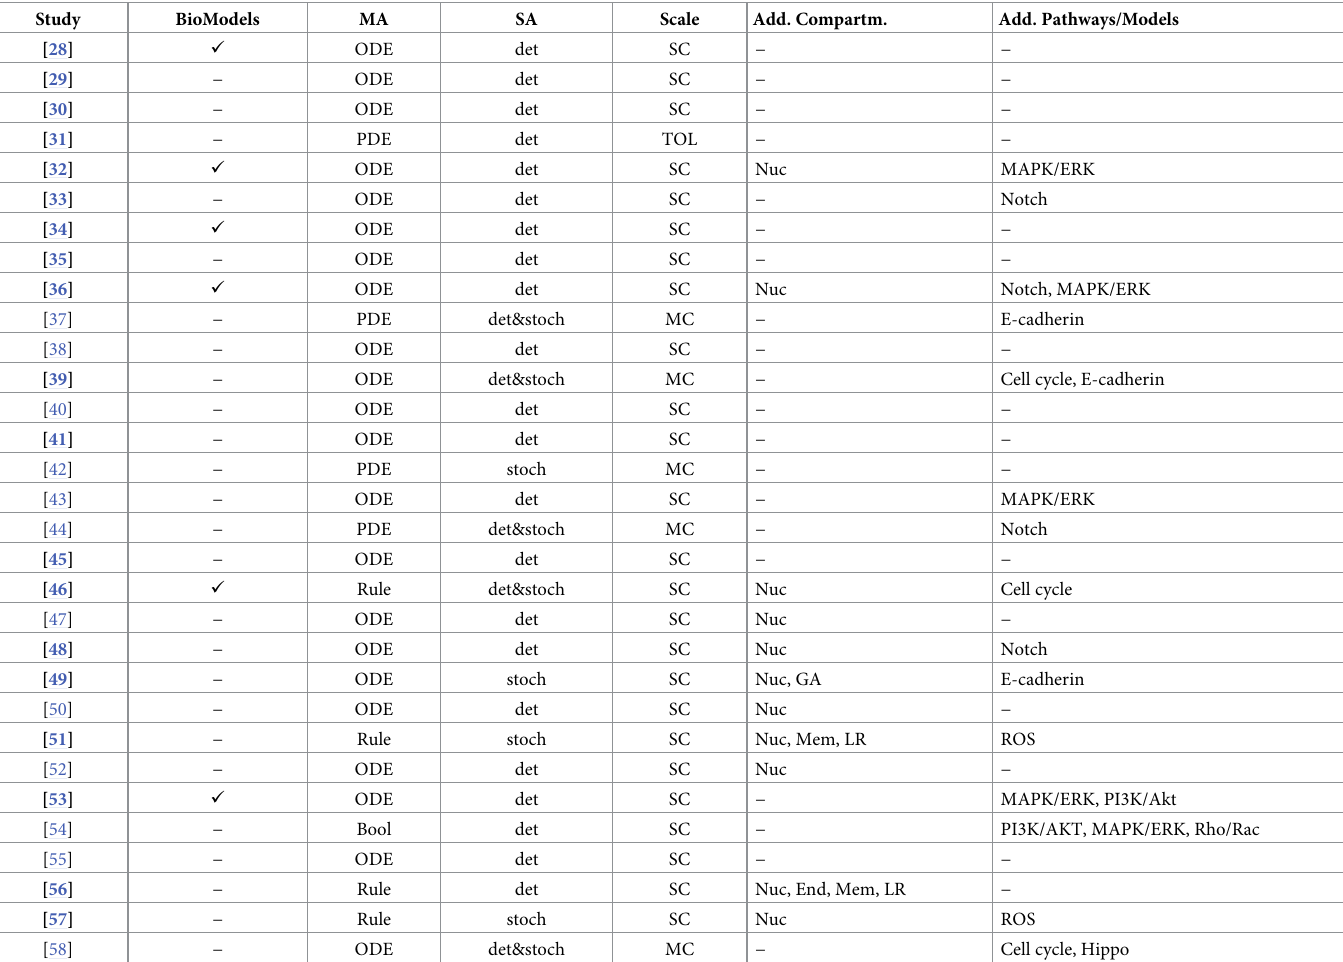
Table 1. Wnt simulation models (as of Feb. 1, 2021) with those included in this study printed in bold. Study BioModels MA SA Scale Add.